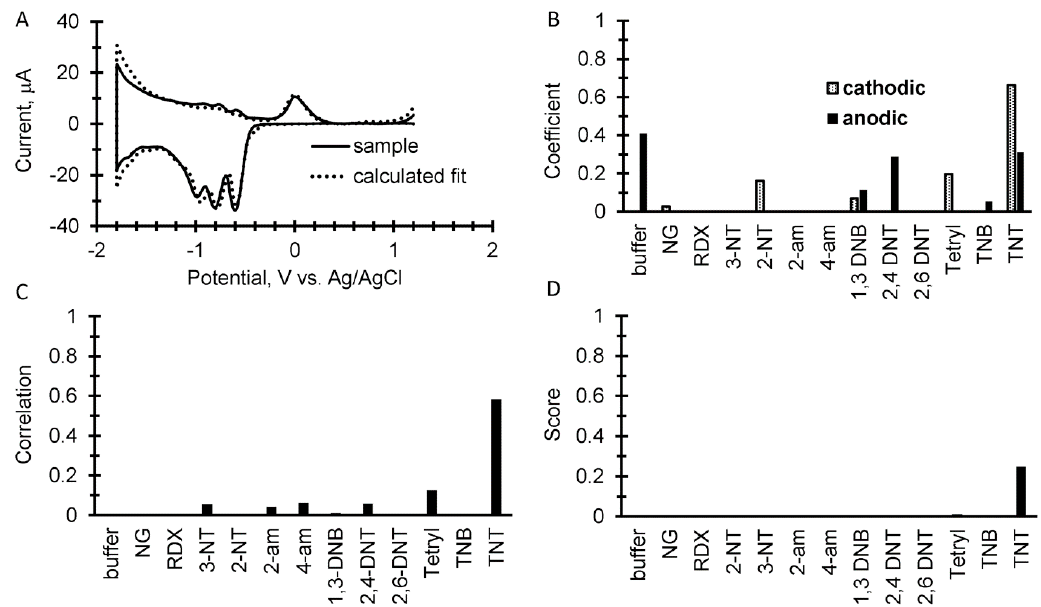
Figure 5. 10 µg of TNT wiped from a bench top. ( A ) An overlay of the background subtracted cyclic square wave voltammogram with the calculated fits of both the anodic and cathodic sweeps using coefficients from the explosive’s library. ( B ) A plot of the resulting coefficients from the fitting calculation for the result shown in A. ( C ) The correlation calculation comparing the measured sample to the square wave voltammetry library. ( D ) The score displayed as the product of the coefficients and correlations.